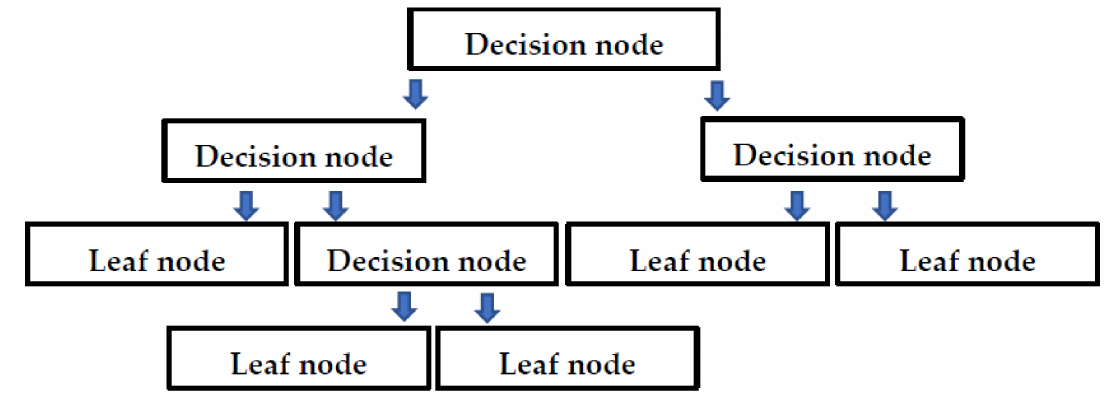
Figure 3. Flow chart of the Decision